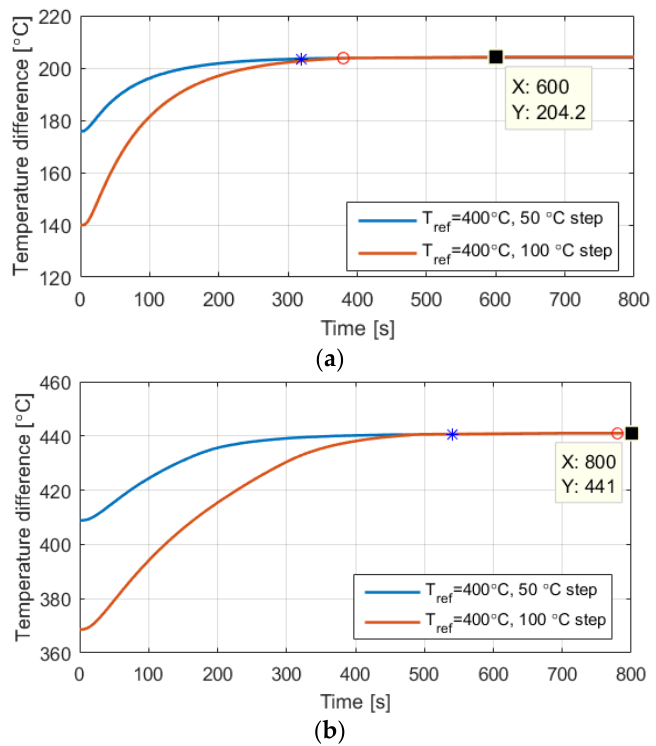
Figure 8. Hot ‐ side temperature response ( T 5 ) of CMO ‐ 25 ‐ 42S with T ref,step = 50 °C, and 100 °C, Figure 8. Hot-side temperature response ( T 5 ) of CMO-25-42S with T ref , step = 50 ˝ C, and 100 ˝ C, at ( a ) T ref_end = 400 °C; and ( b ) T ref_end = 800 °C. at ( a ) T ref_end = 400 ˝ C; and ( b ) T ref_end = 800 ˝ C.